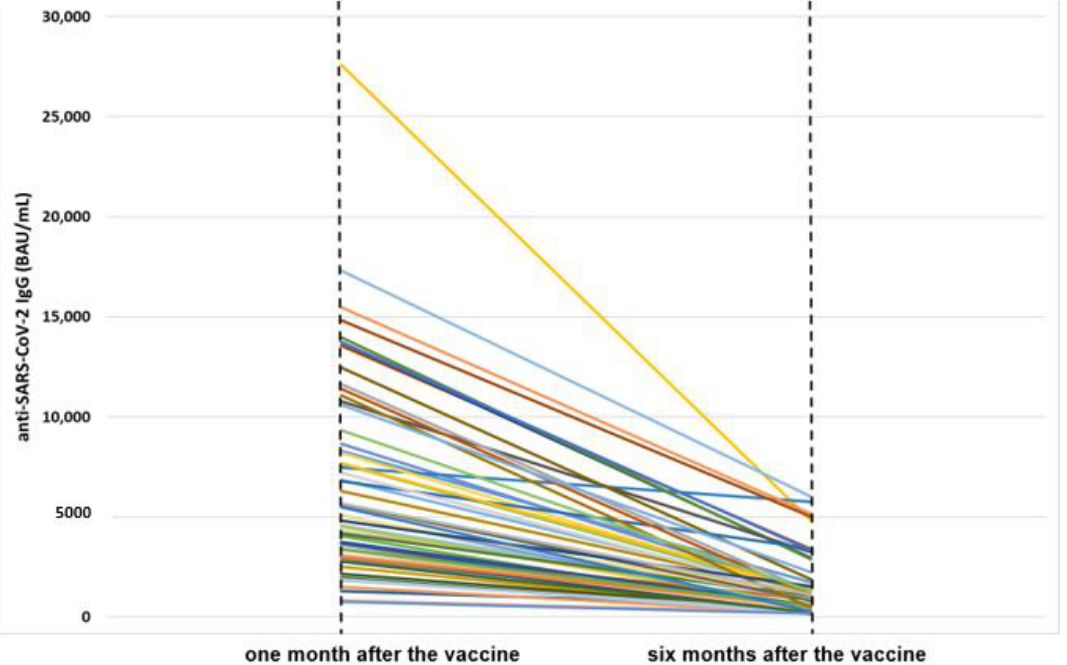
Figure 1. Decrease in the anti-SARS-CoV-2 neutralizing IgG titer: trend of the levels detected one month vs. six months after the anti-COVID-19 BNT162b2 vaccine, graphically represented with a line for each of the 63 workers of the nursing home included in the study sample.